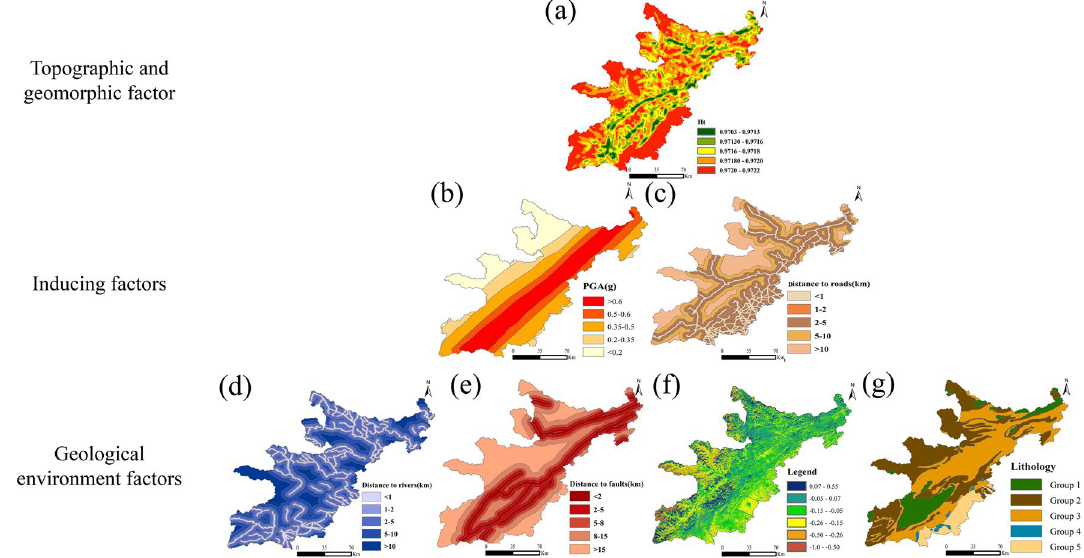
Figure 4. Conditioning factors of landslides: ( a ) Ht, ( b ) PGA, ( c ) distance to roads; ( d ) distance to rivers, ( e ) distance to faults, ( f ) NDVI, and ( g ) lithology (Names of software: ArcGIS 10.5 and Office